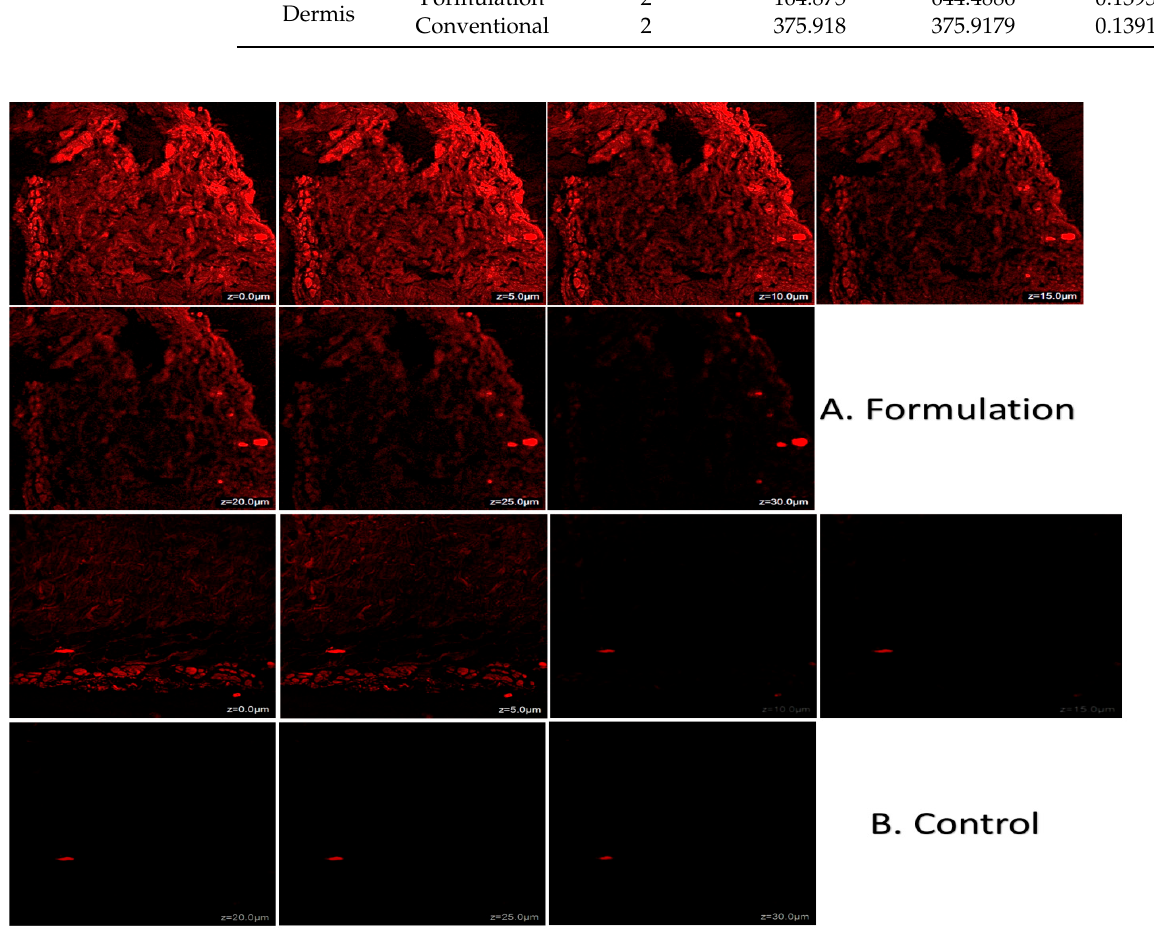
Figure 9. Images of CLSM within the perpendicular cross-section of optimal skin surface of rats.